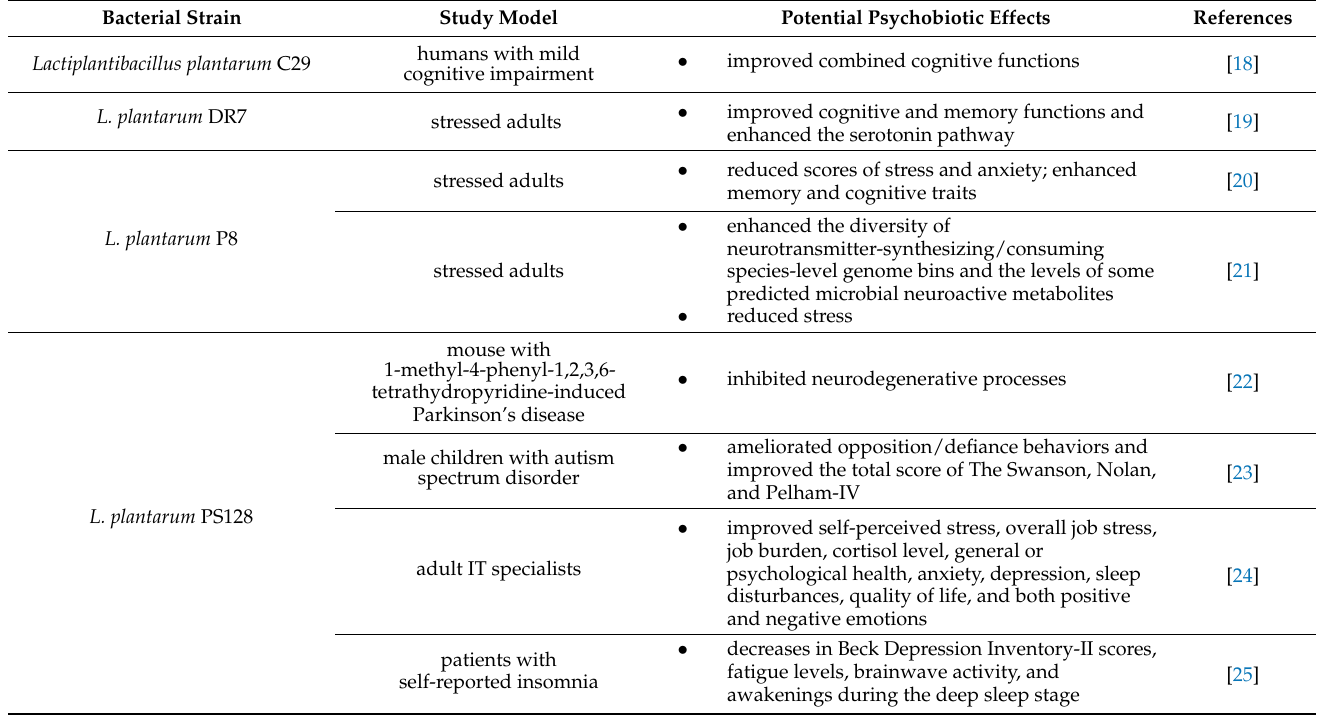
Table 1. Potential psychobiotic effect of probiotic bacterial